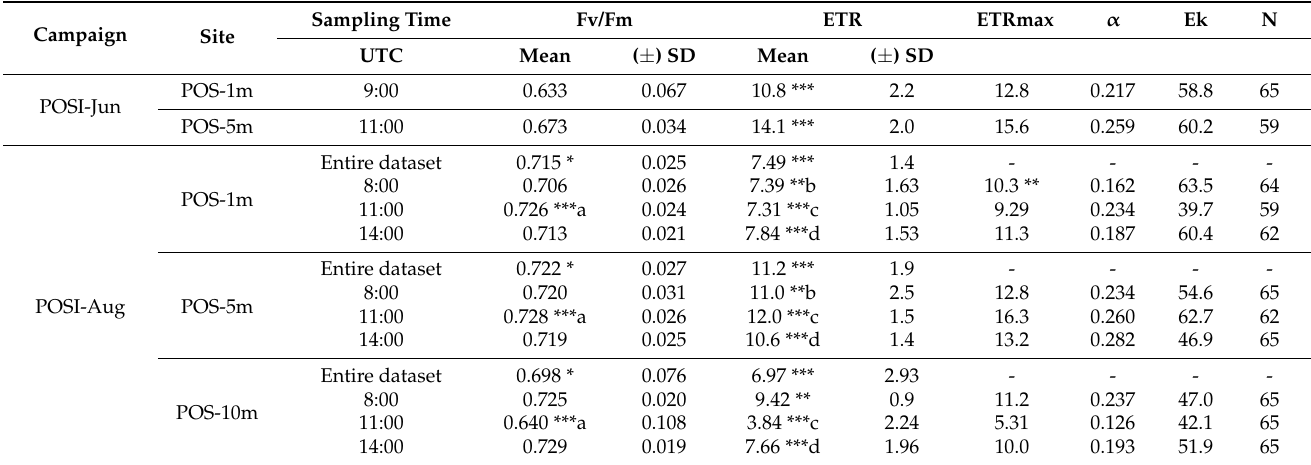
Table 4. Photosynthetic parameters of P. oceanica sampled at POS-1m, POS-5m, and POS-10m during POSI-Jun and POSI- Aug campaigns. * ANOVA p < 0.05; ** ANOVA p < 0.01; *** ANOVA p < 0.001. a: ANOVA post hoc POS-1m-POS10m; POS-5m-POS-10m; b: ANOVA post hoc POS-1m-POS-5m; c: ANOVA post hoc POS-1m-POS-10m; POS0-5m-POS-10m; POS-1m-POS-5m; d: ANOVA post hoc POS-1m-POS-5m; POS-5m-POS-10m.